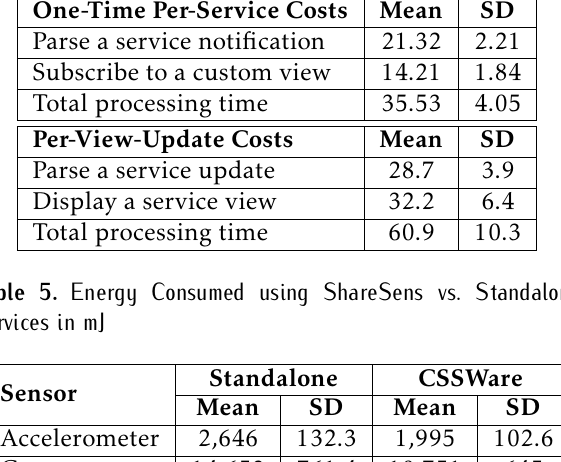
Table 2. Average Processing Time at the Server Side in ms